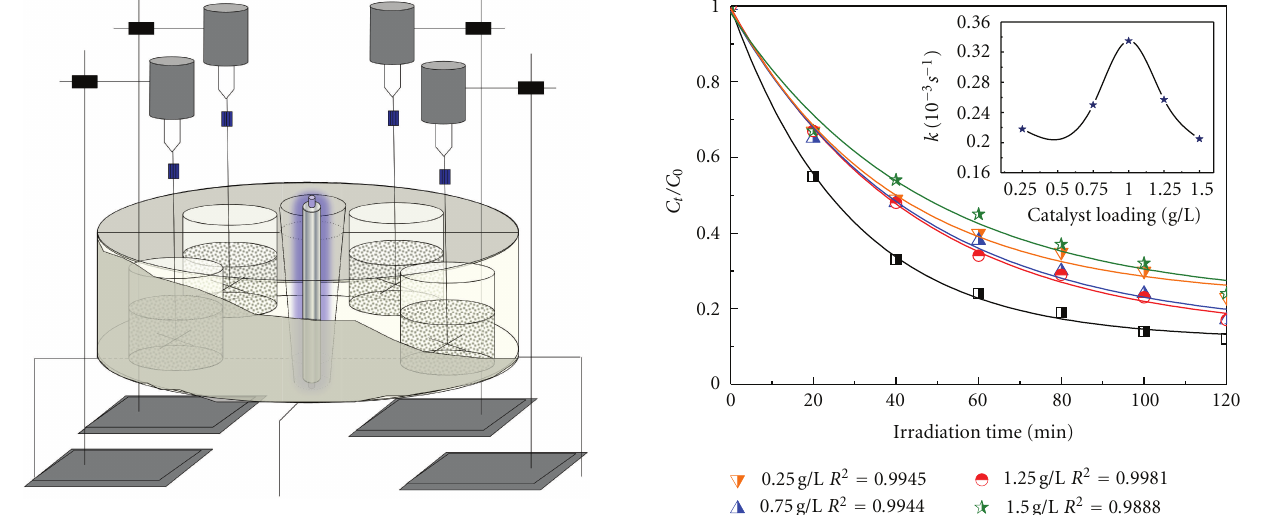
Figure 2: Schematic diagram of the photoreactor.